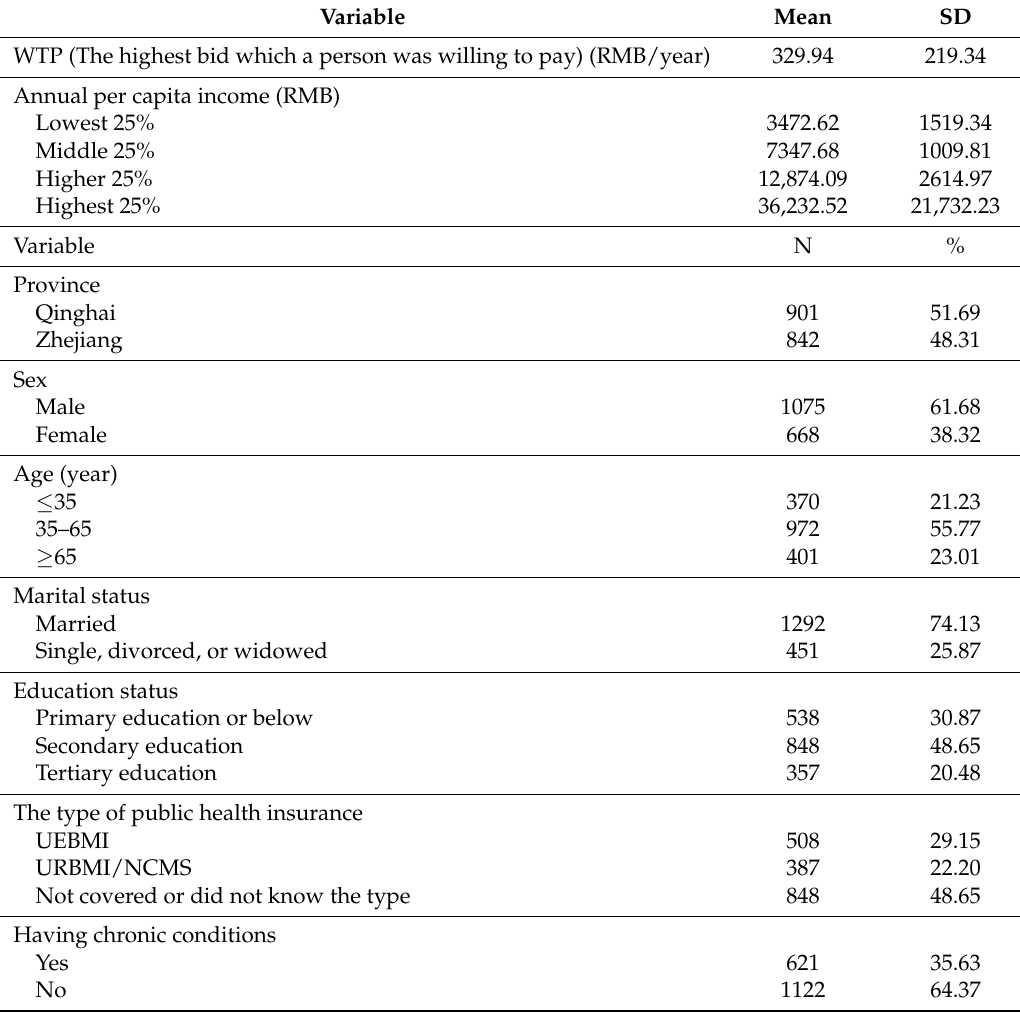
Table 2. Descriptive Statistics for the variables ( N =